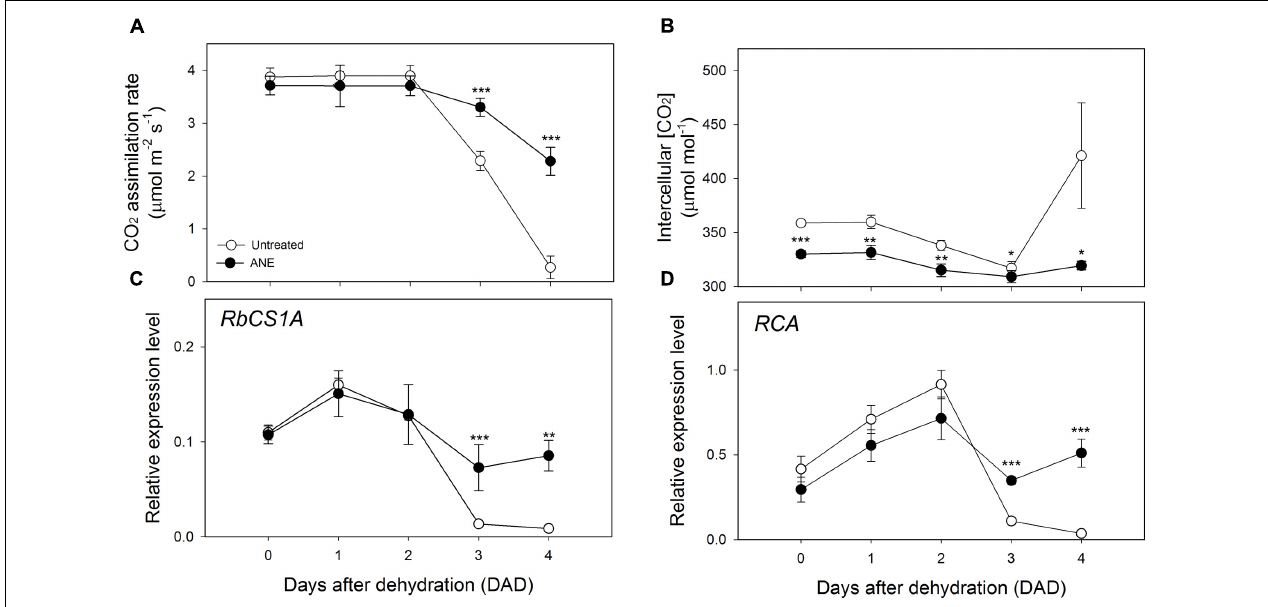
FIGURE 3 | Photosynthetic CO 2 uptake and modulation of intercellular CO 2 concentration linked with the expression analysis of Rubisco quantity and activity genes. Time 0 is the dehydration stress starting time and it corresponds exactly with the last day of Ascophyllum nodosum extract (ANE) treatment. Measurements of CO 2 assimilation rate (A) and intercellular CO 2 concentration (B) , each dot shows the mean ± SE of nine biological replicates. Expression level analysis of RBCS1A (C) and RCA (D) during 4 days after dehydration (0–4 DAD). Each dot shows the mean ± SE of four biological replicates. Untreated (white dot) and ANE treated (black dot) samples were analyzed by one-way ANOVA ( P < 0.05), ∗ P ≤ 0.05; ∗∗ P ≤ 0.01; ∗∗∗ P ≤